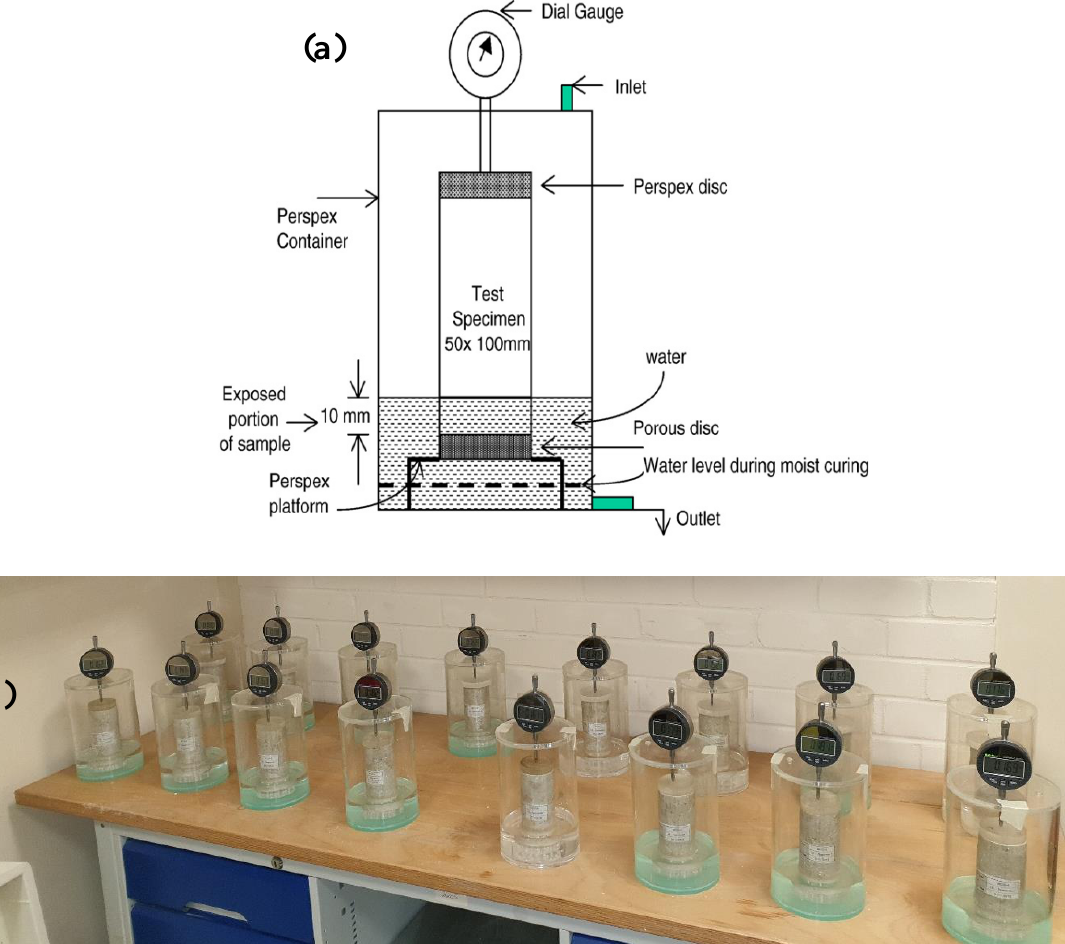
Figure 1. Showing ( a ) schematic diagram of a Perspex cell and, ( b ) group test set-up used for determining of linear expansion.